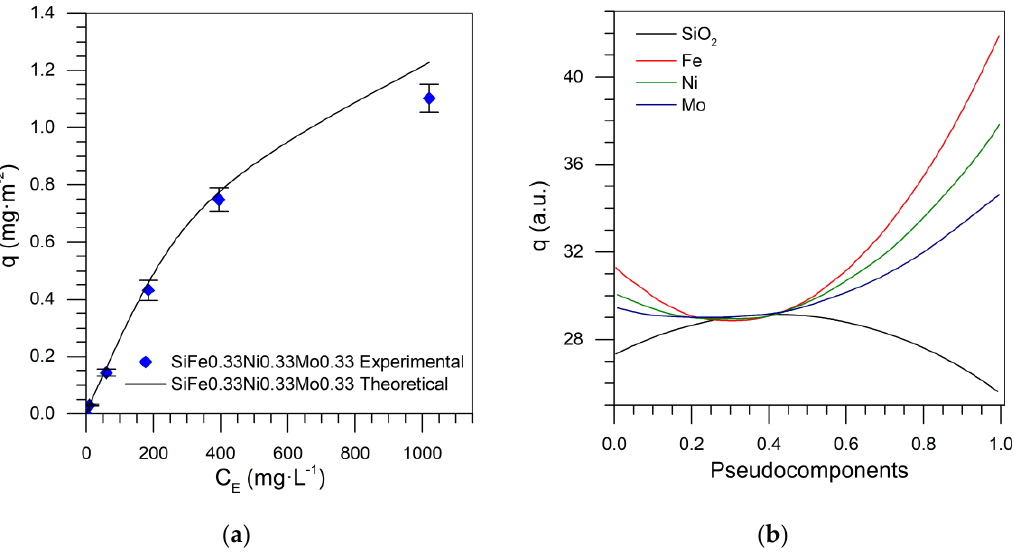
Figure 15. ( a ) Asphaltene sorption isotherms at 25 ◦ C with SiFe0.0.33Ni0.33Mo0.33, experimental and SLE adjusted data, and ( b ) trace plot at 100 mg · L − 1 for Si-Fe-Ni-Mo mixture